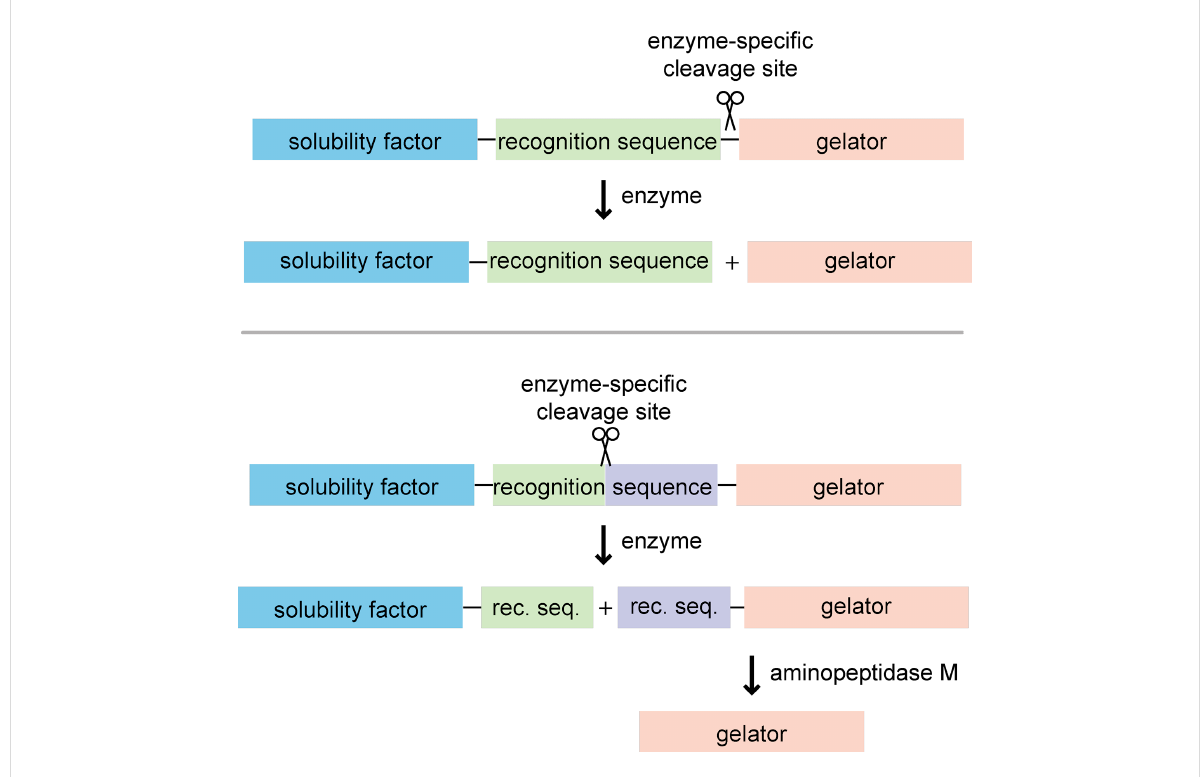
Figure 7: Two complementary approaches for sensing protease activity using gel formation.